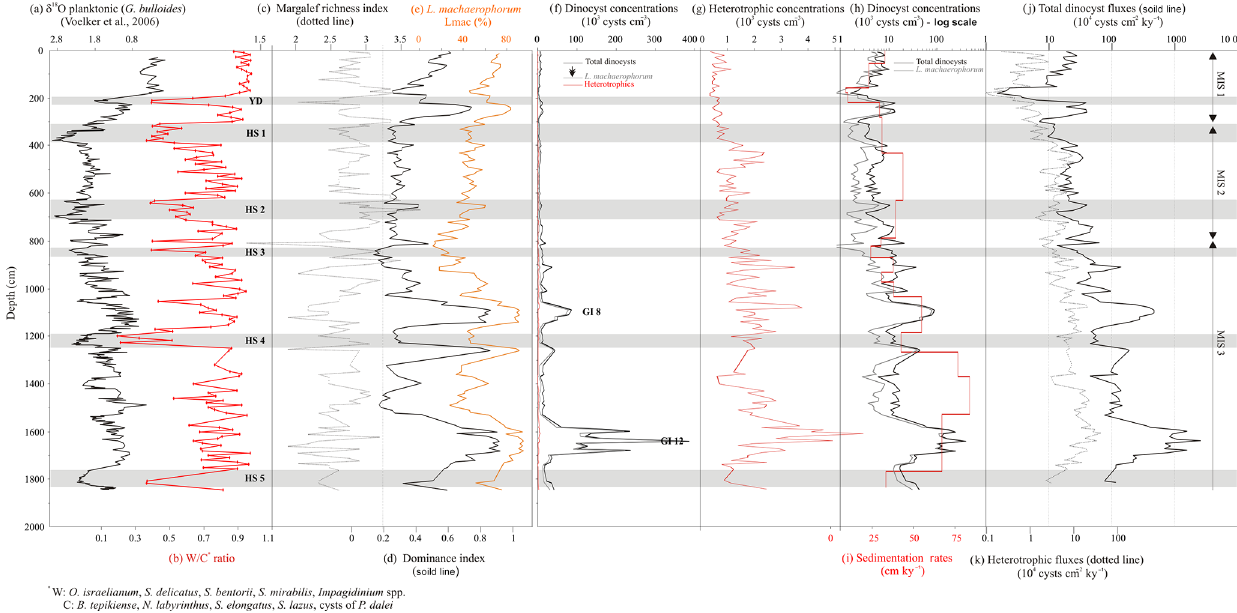
Figure 4. Data from core MD99-2339 compared to depth (cm). δ 18 O planktonic monospecific record of core MD99-2339 ( a ; Voelker et al., 2006) is presented in parallel with the W/C qualitative index of surface temperatures (b) . Diversity indexes (species richness according to the Margalef index, c , and dominance, d ) are drawn in parallel with percentages of the major species L. machaerophorum (e) . Different calculations of dinocyst concentrations (f, g) are represented on a linear scale, while (h) illustrates total dinocyst and L. machaerophorum concentrations on a logarithmic scale, compared with sedimentation rates (i) and dinocyst fluxes (j) . GI: Greenland Interstadial. Grey bands indicate Heinrich Stadials (HS) and the Younger Dryas